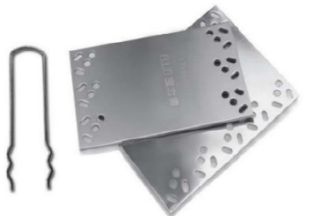
Figure 2. Detail drawing of stainless steel shear connector.